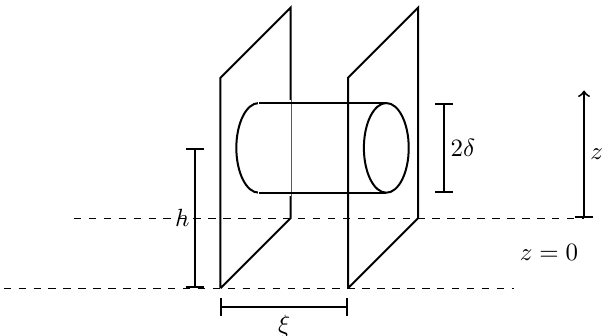
Figure 5. When the caps in figure 4(a) are expanded to R . ‘/ 2 , the surfaces in neighboring fundamental domains almost touch. Close to the point where they would touch for R = ‘/ 2 , the two surfaces can be approximated as two parallel planes, as shown here. The formation of a small cylindrical bridge as shown then decreases the area, leading generically to the phase in figure